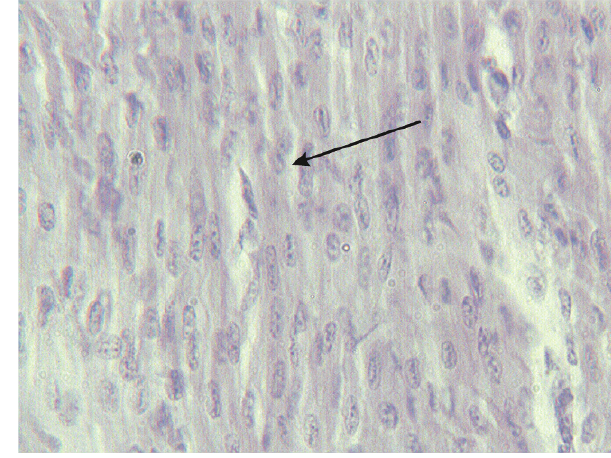
Figure 2 - Hypereosinophilia of cardiomyocytes.